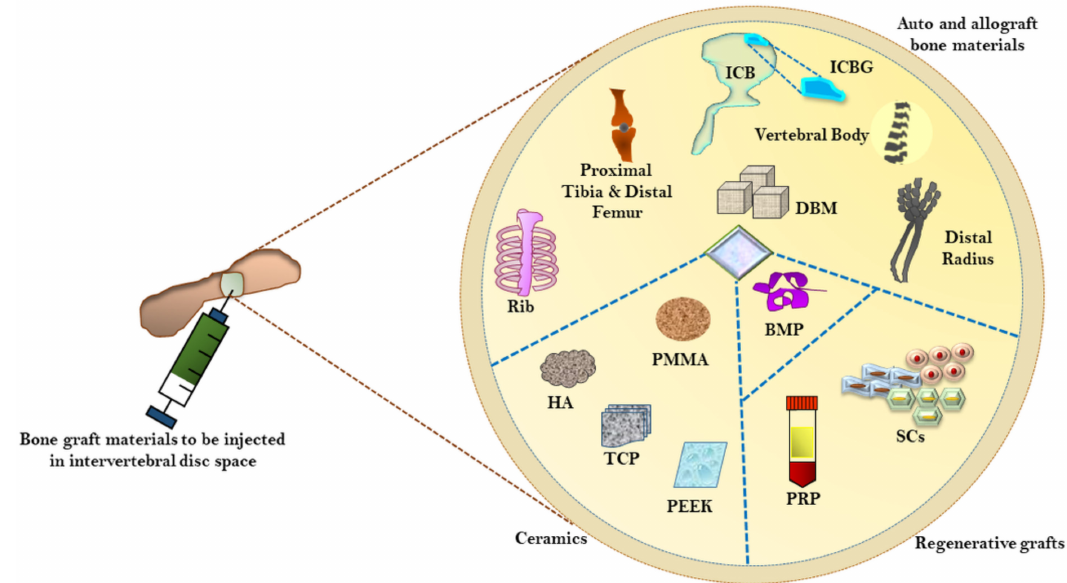
Figure 2. Overview of bone graft materials available for interbody fusion. Currently, the three categories of bone graft materials are being explored, which include ceramics, auto/allografts, and regenerative grafts. BMP: Bone morphogenetic protein, DBM: Demineralized bone matrix, HA: Hydroxyapatite, ICBG: Iliac crest bone graft, PRP: Platelet-rich Plasma, PEEK: Polyetheretherketone, PMMA: Polymethylmethacrylate, SC: Stem cells, TCP: Tricalcium